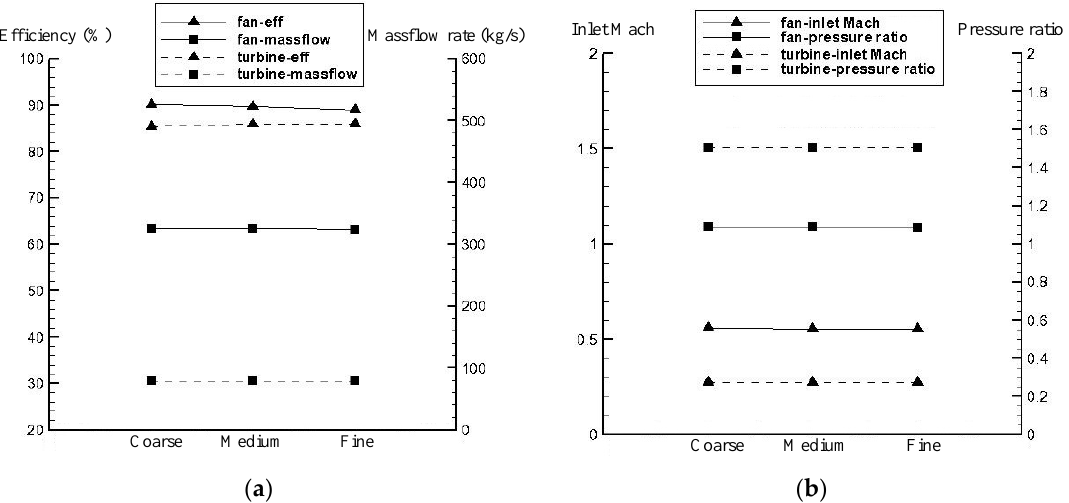
Figure 5. Grid independence results. ( a ) Efficiency and mass flow rate; ( b ) Inlet Mach number and pressure ratio.